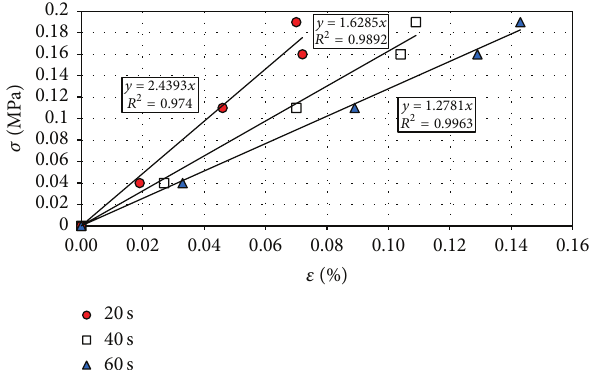
Figure 2: Isochronous lines of deformation of asphalt concrete.